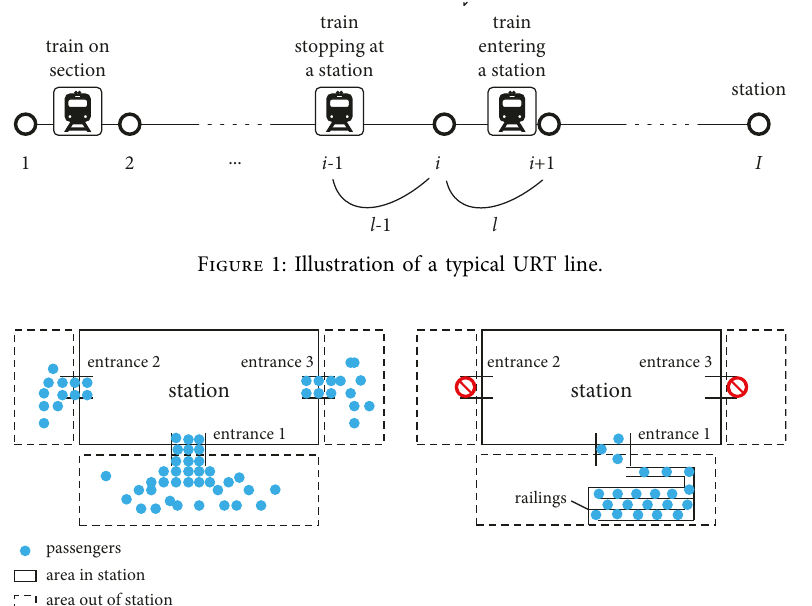
Figure 2: Comparison of passenger inflows at a station with and without control. (a) Without control. (b) With